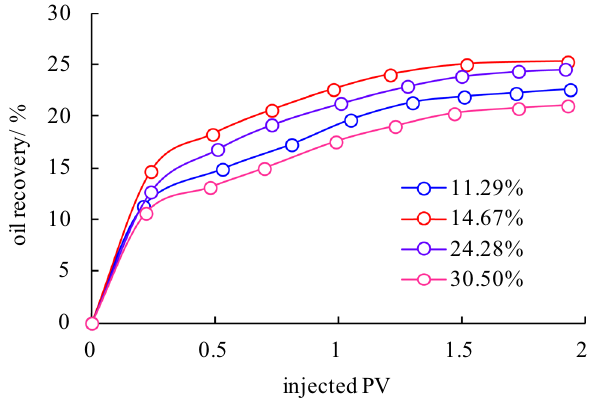
Fig. 3 Oil recovery varies with converting moment